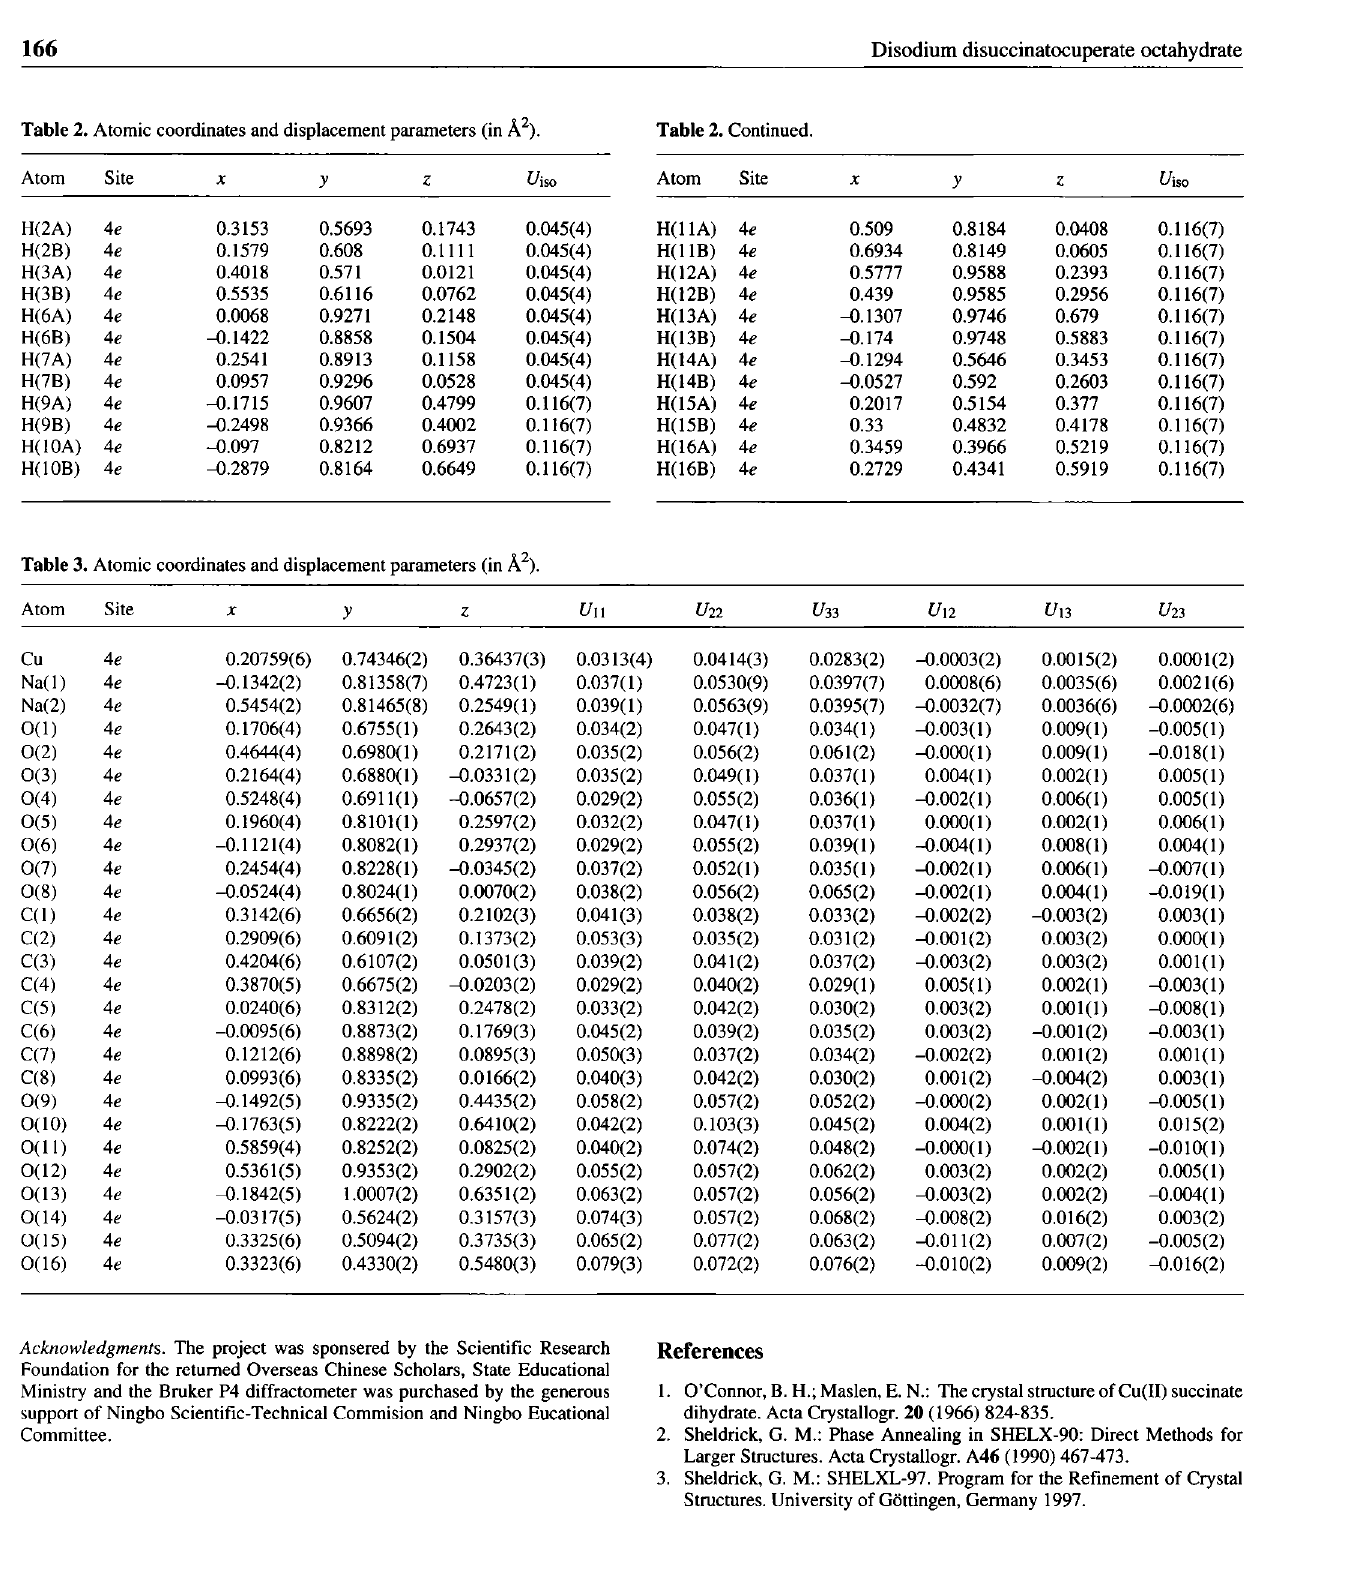
Table 3. Atomic coordinates and displacement parameters (in Ä 2